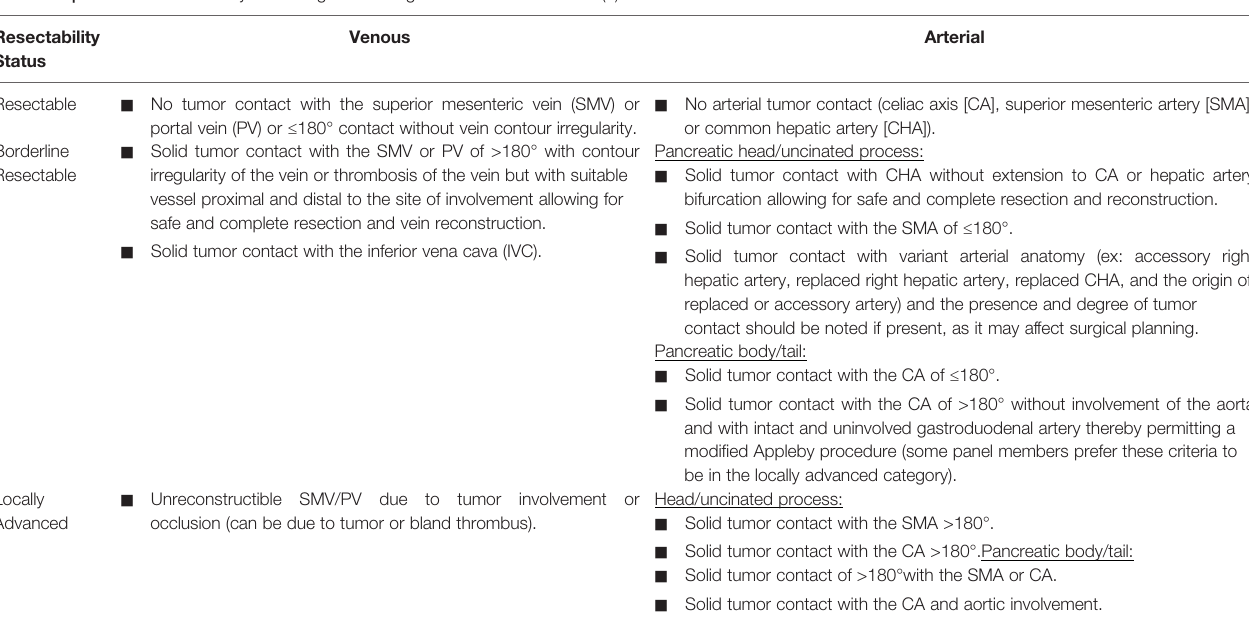
TABLE 1 | Criteria of resectability according to NCCN guidelines version 2.2021